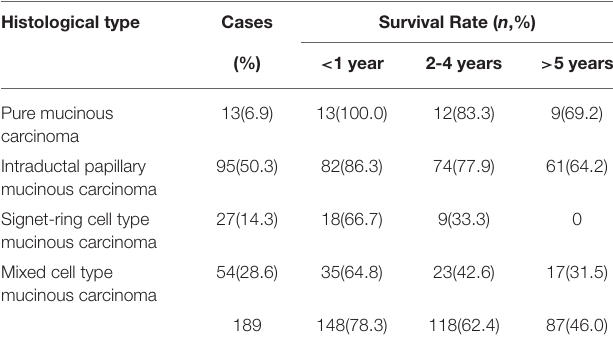
TABLE 5 | Comparison of survival rate of gastric adenocarcinoma with mucinous differentiation. Histological